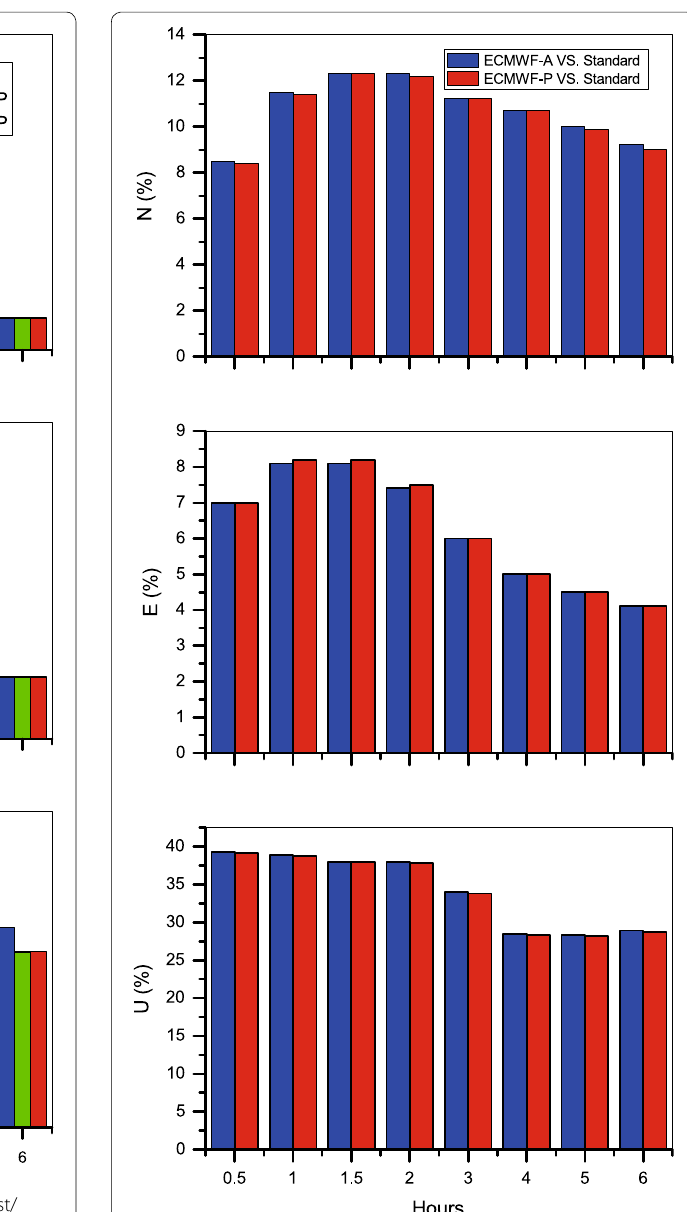
Fig. 7 Specific increased ratios of the two ECMWF-augmented PPP results compared to standard PPP results in BeiDou-only at different session length. The improvements in percentage for ECMWF-augmented PPP results using analysis and prediction data are displayed in blue and red,